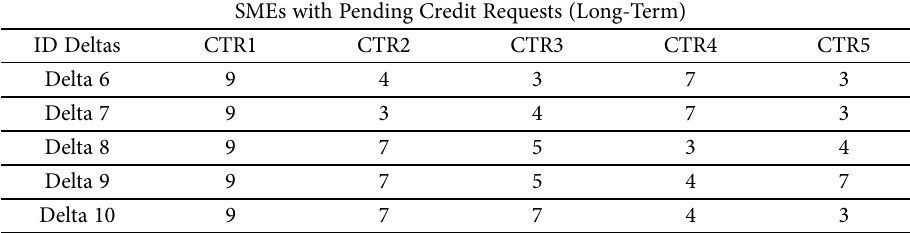
Table 8. Assessment matrix for pending credit requests